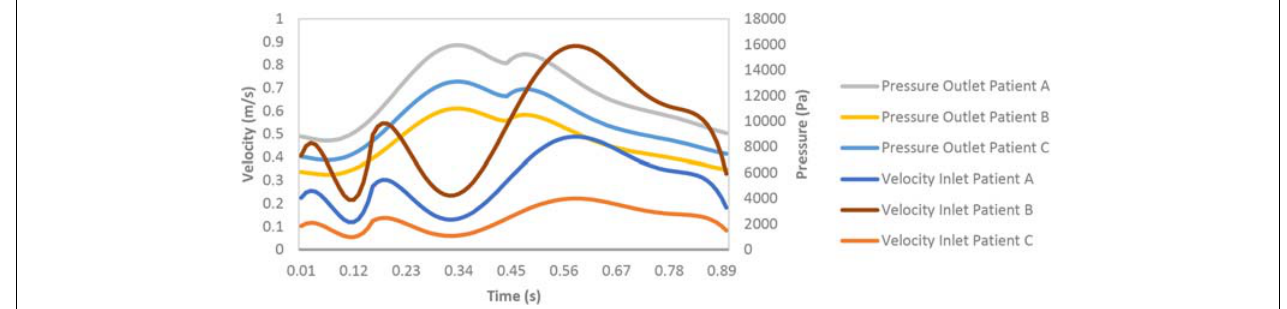
FIGURE 1 | Hyperemic boundary conditions: inlet velocity and outlet